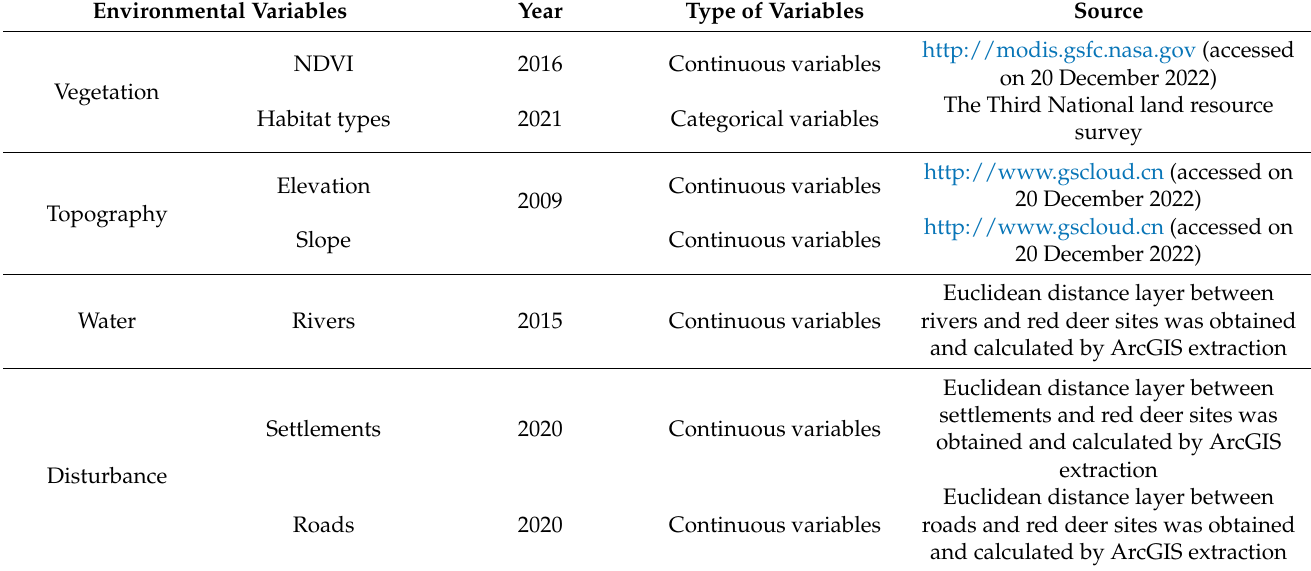
Table 1. The environment variables used in the MaxEnt model and their